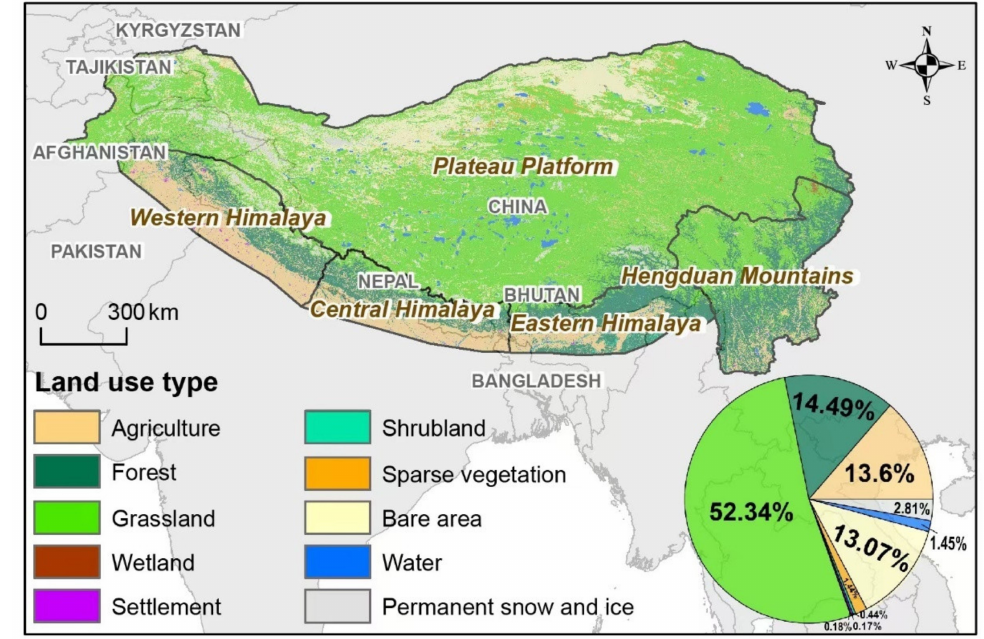
Figure 3. The land-use type maps in the study